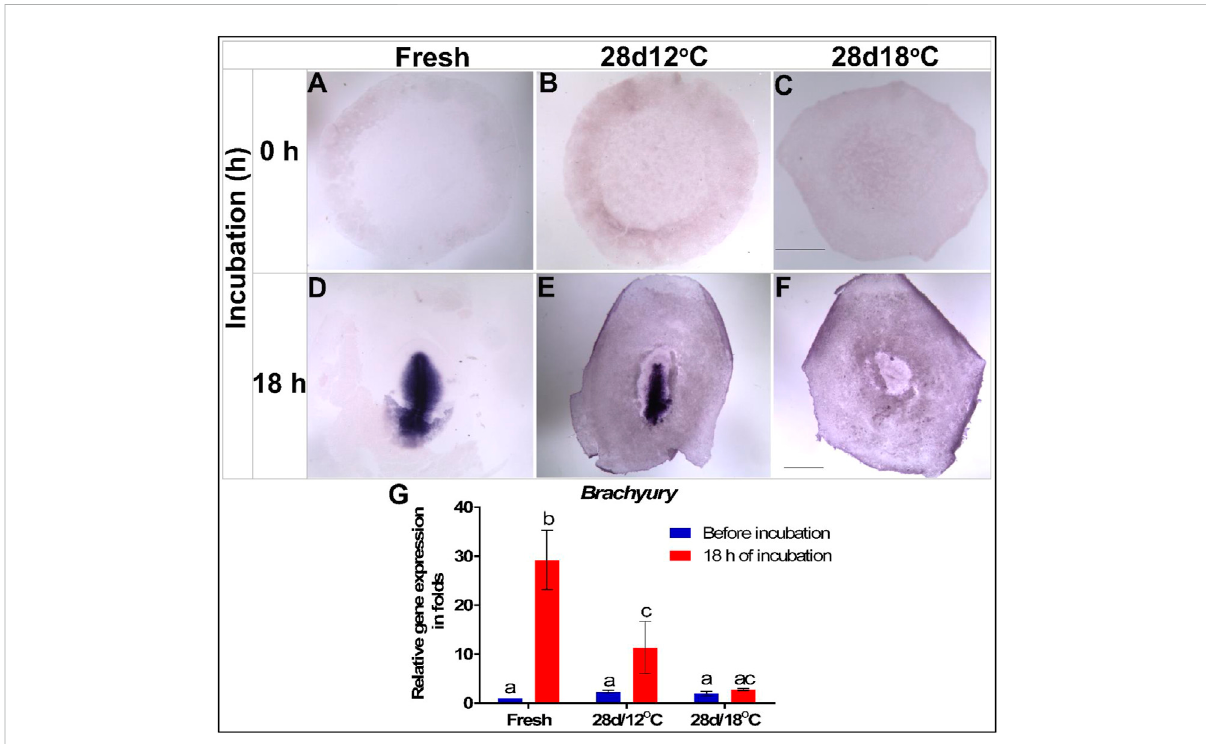
FIGURE 5 Expression of Brachyury(TBXT) geneinembryosfollowingstorage,andfollowing18 hofincubationintheresumption phase. (A – C) TBXT gene expression in freshly laid (X EG&K), 28 days/12 ° C (XI EG&K), and 28days/12 ° C (XIII EG&K) stored embryos, respectively. (D – F) Expression pattern of TBXT following 18 h of incubation, in freshly laid (3 H&H), 28 days/12 ° C (3 + H&H), and 28 days/12 ° C (1 H&H) stored embryos, respectively. (G) Quanti fi cationof TBXT geneexpressionin6differentembryogroups usingreal-time PCR. GAPDH wasusedfor geneexpressionnormalization andthe TBXT expressioninthegroupsisrepresentedasafoldofchangerelativetothefreshcontrol.One-wayANOVAanalysisof6differentembryo groups; F value = 23.64; different connecting letters denote that the expression of TBXT is signi fi cantly different between groups; Fresh, a vs. b: p < 0.0001; 28 days/12 ° C, a vs. c: p = 0.007. Bar = 1